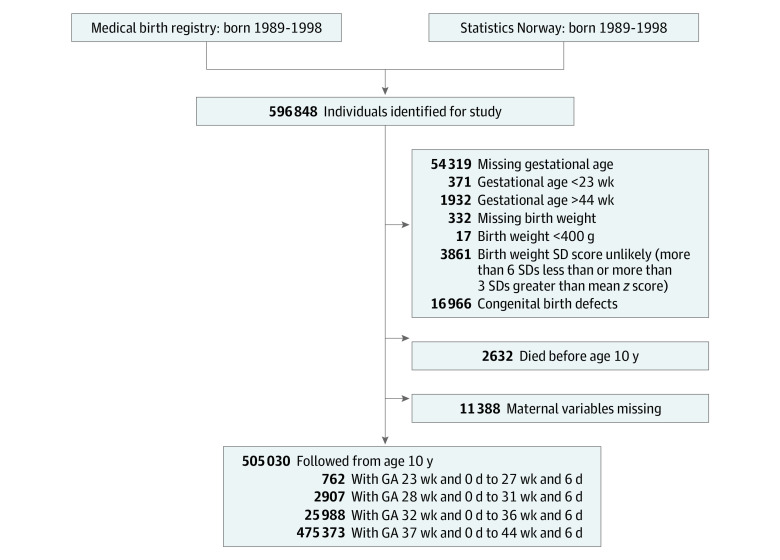
Study PopulationGA indicates gestational age.